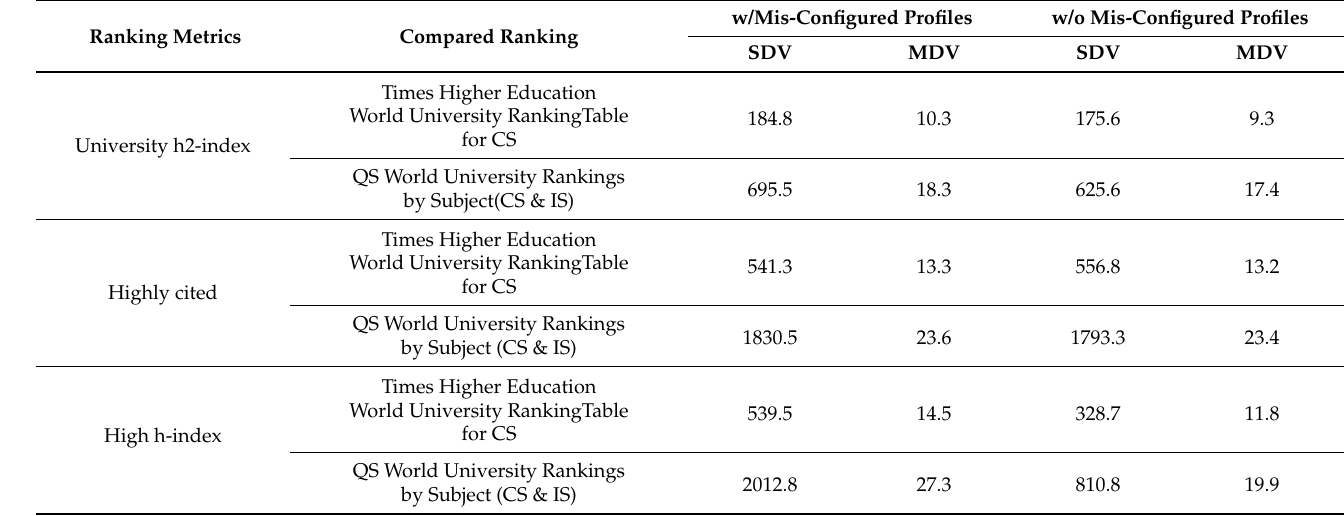
Table 7. Comparison of different